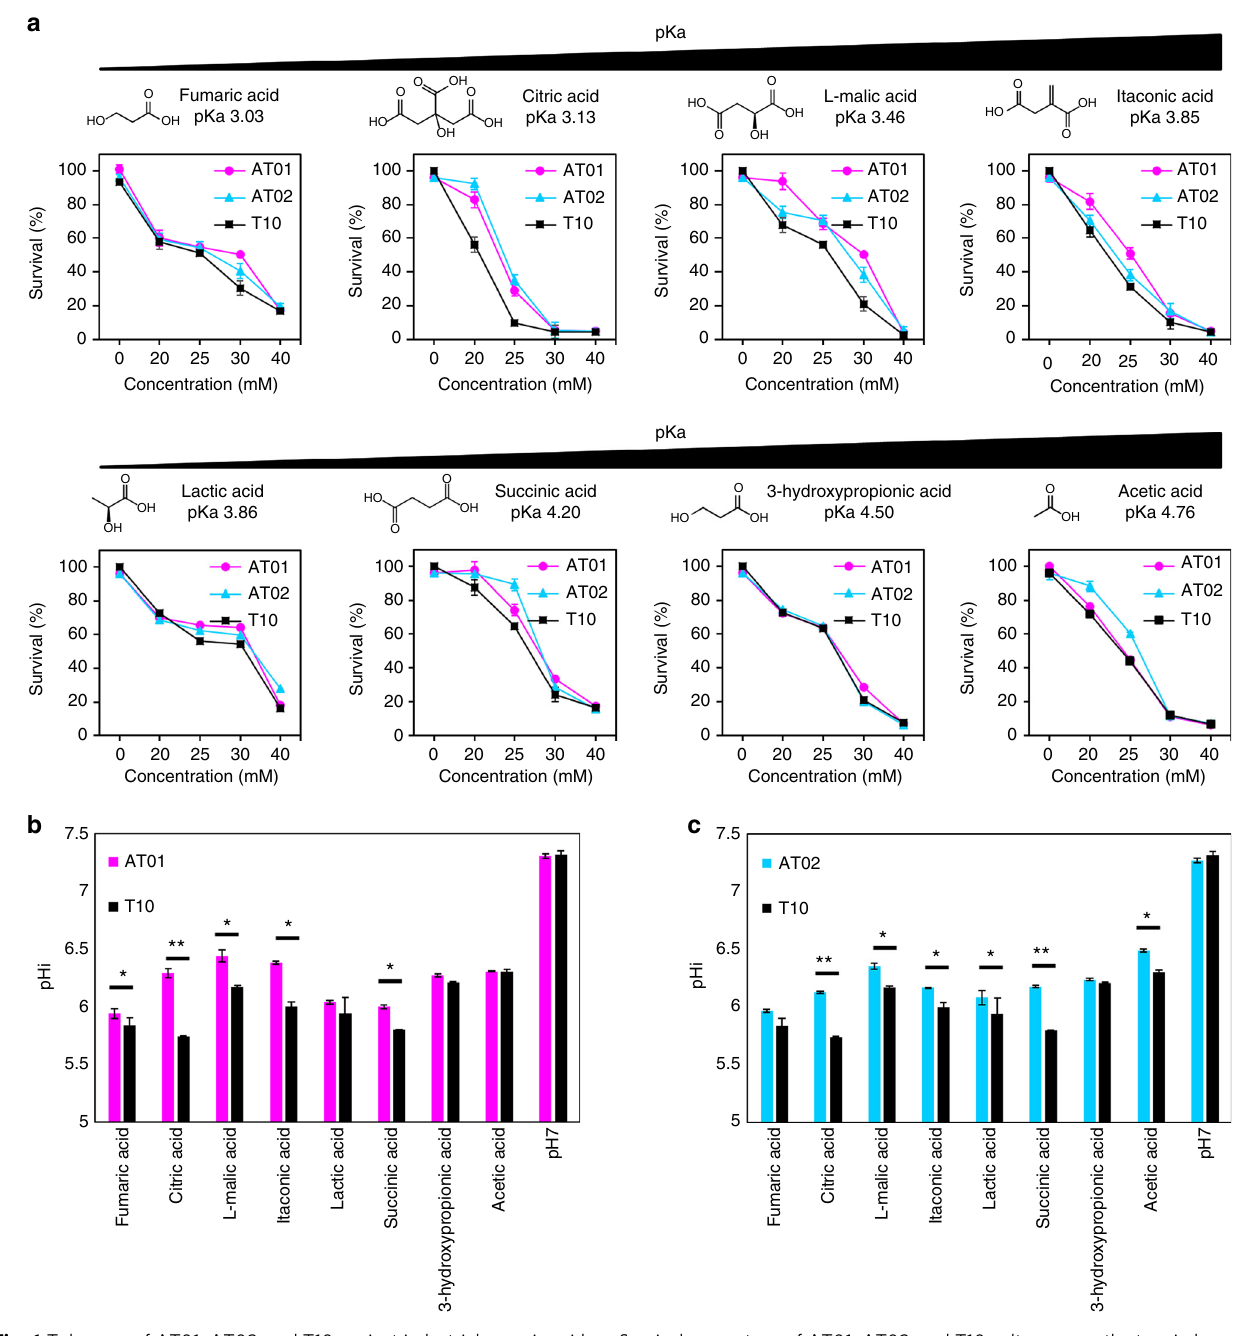
Fig. 6 Tolerance of AT01, AT02, and T10 against industrial organic acids. a Survival percentage of AT01, AT02, and T10 cultures growth at varied organic acid concentrations at (37 °C, 12 h) are reported. For each organic acid, the stationery-phase cell density at each concentration were divided against maximal cell density grown in neutral media (pHe 7.0). b Comparison of intracellular pH (pHi) of AT01 and T10 under organic acids challenge (25 mM). c Comparison of intracellular pH (pHi) of AT02 and T10 under organic acids (25 mM). The pHi values are measured 6 h upon organic acid addition. Student t -test: asterix = P < 0.05, double asterix = P < 0.01. The data represent the mean of three biological